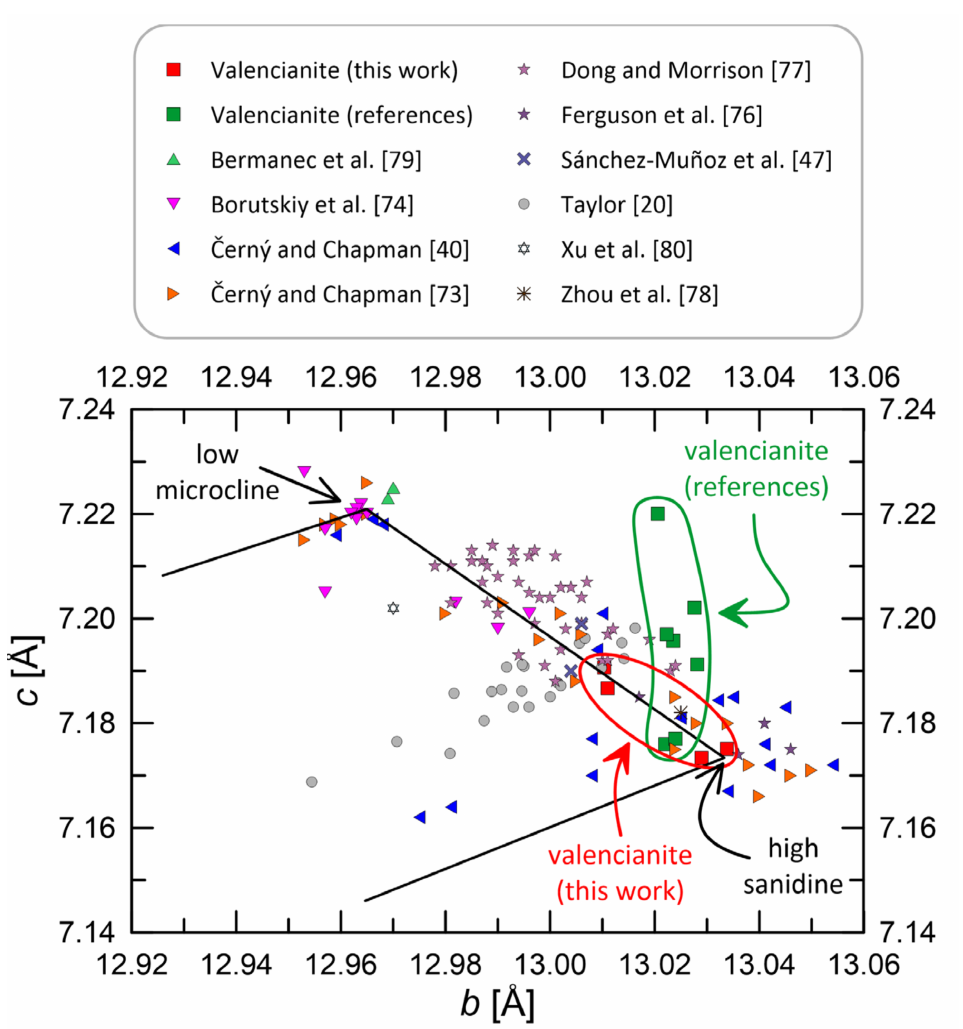
Figure 6. A b-c plot [52] from valencianite and adularia, including data from this work and bibliogra- phy. Black lines are the joints connecting the alkali feldspars series.